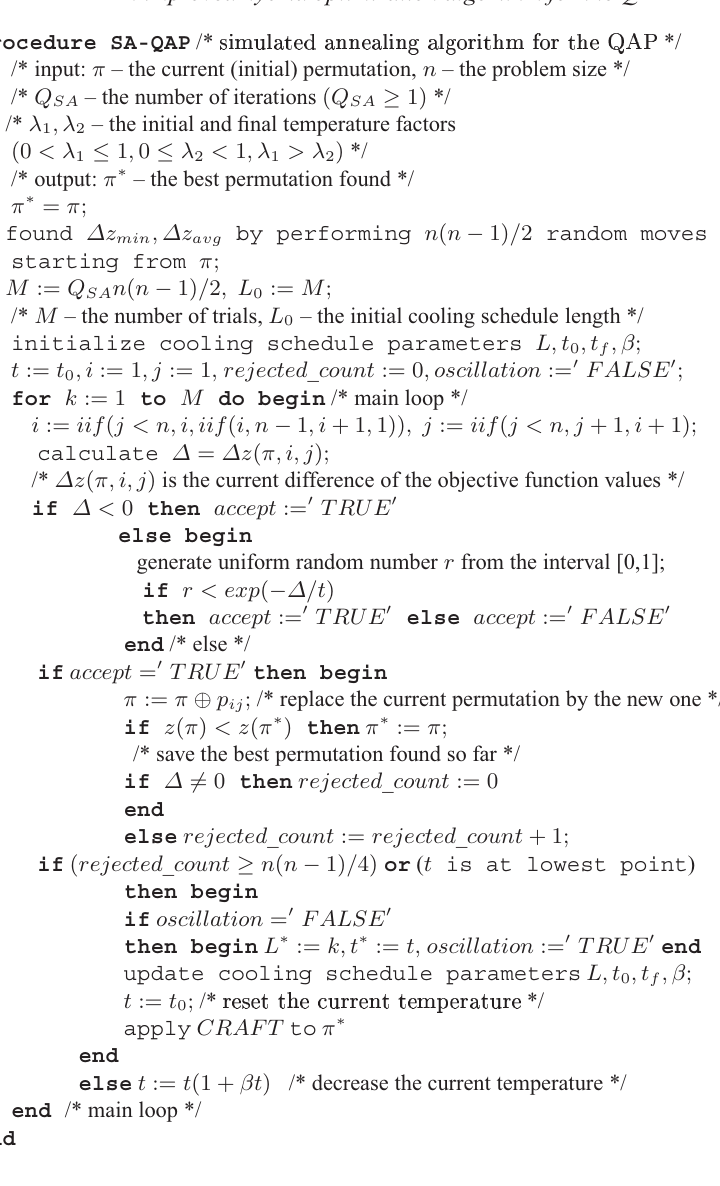
Figure 8. Pseudo-code of the simulated annealing algorithm for the QAP. Here ∆z ( π, i, j ) is calculated according to